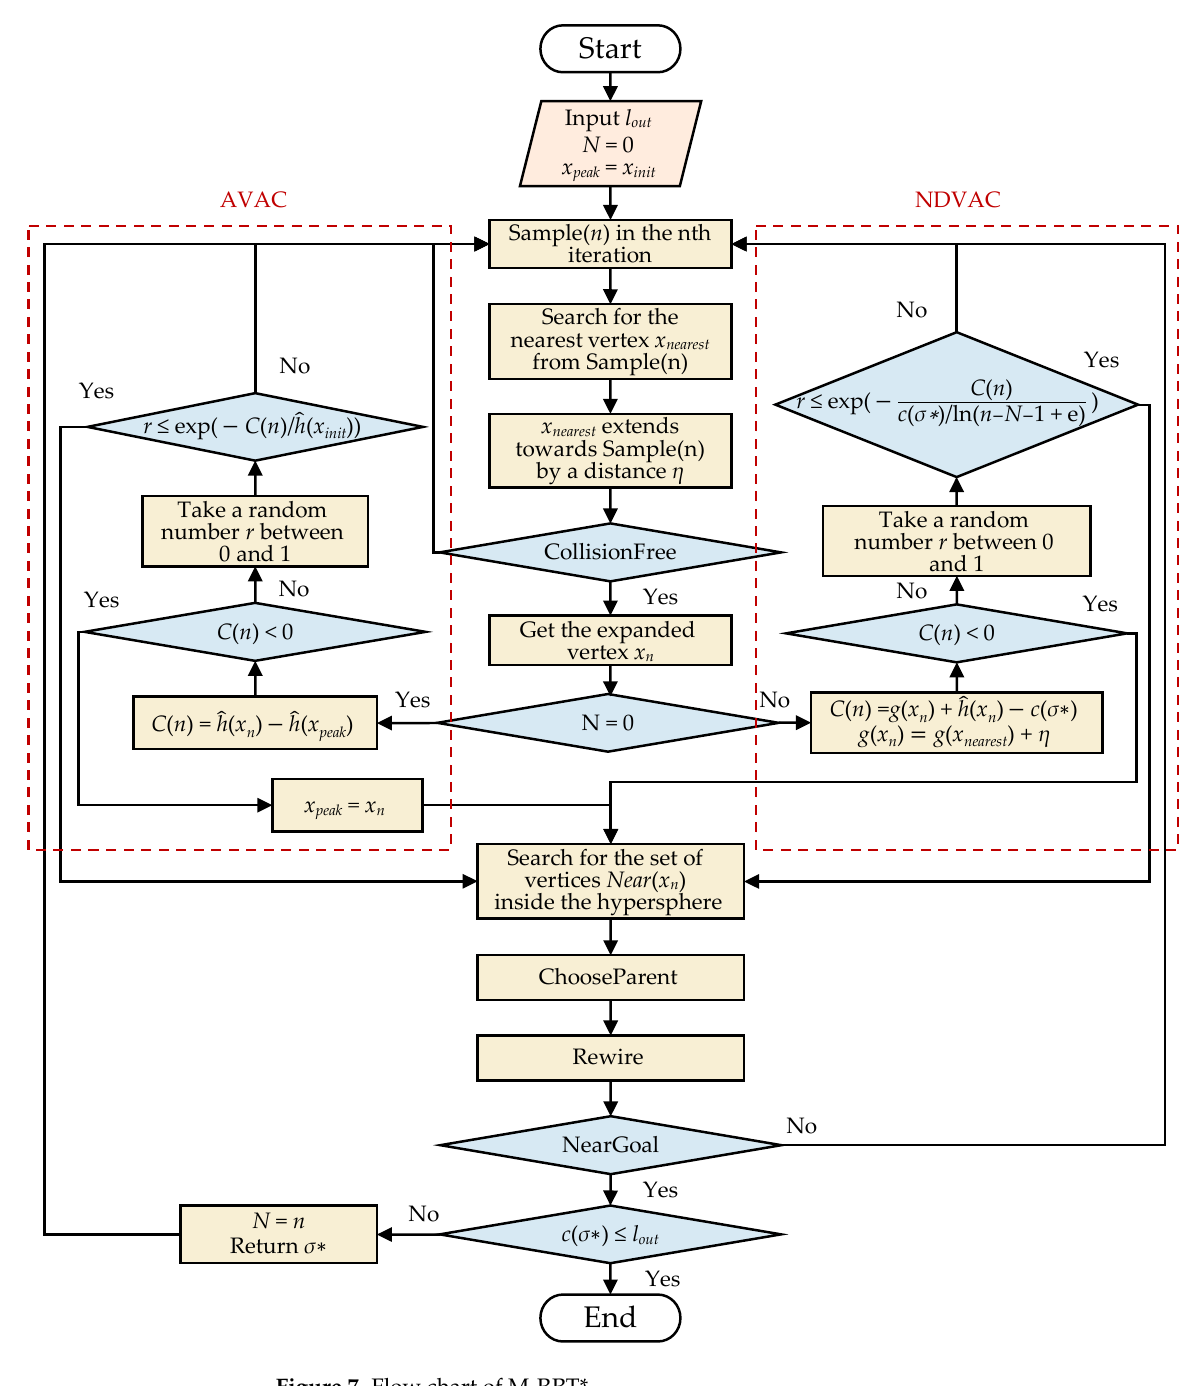
Figure 7. Flow chart of M-RRT*.